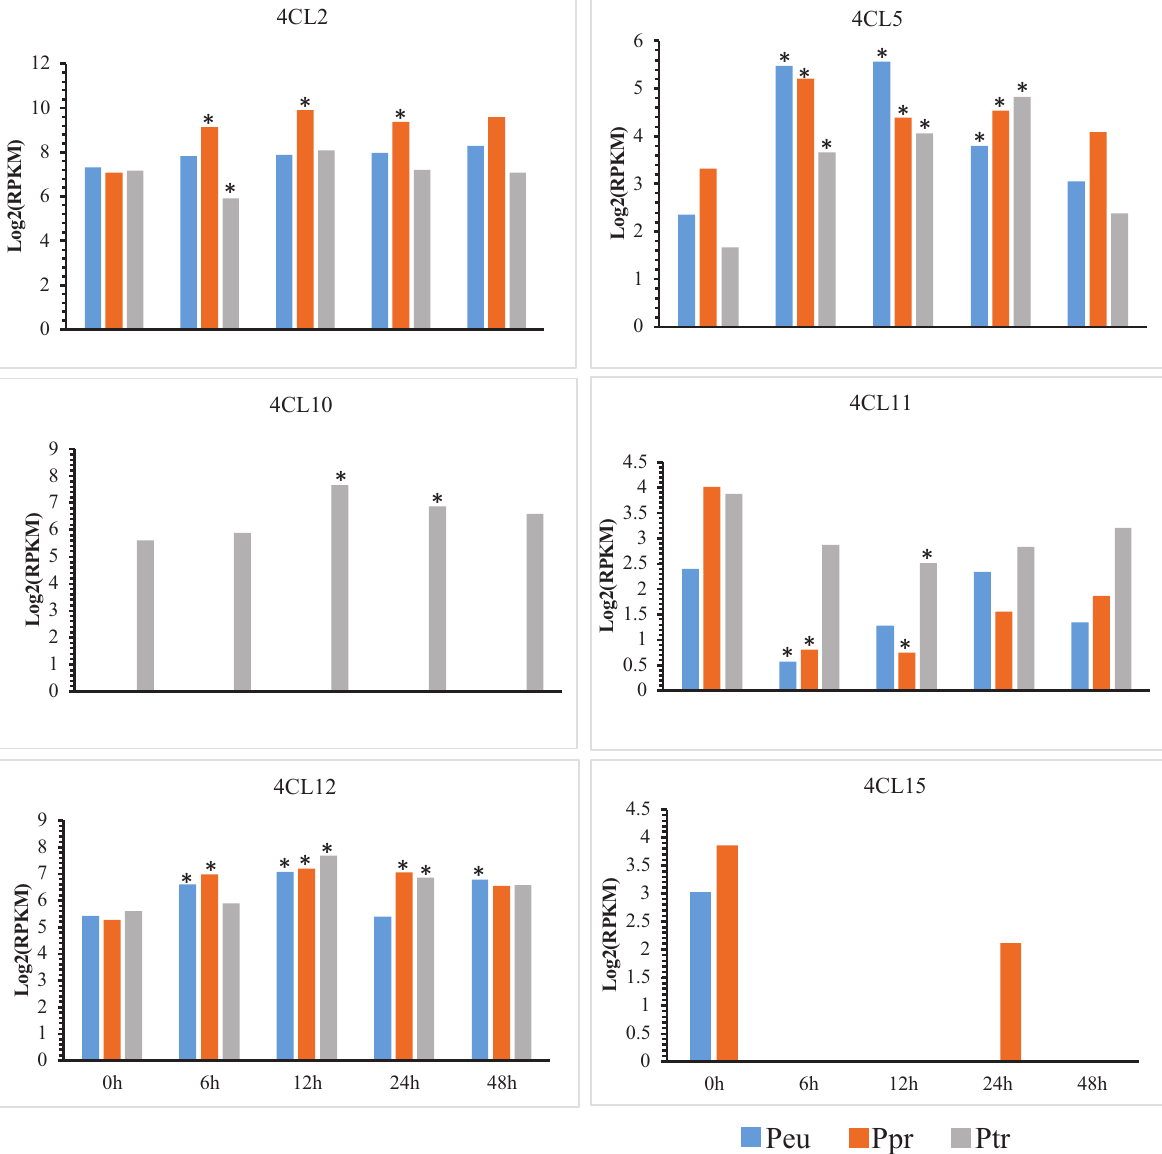
Figure 6. Expression analysis of the orthologous 4CL genes under salt stress. Transcription analysis of the relative expression levels of six orthologous 4CL genes specific to three species under salt stress except 4CL9 , which was not expressed in neither un-stressed nor stressed calluses, and the orthologous genes ( 4CL15 ) with (cid:2) ( dN/dS ) > 1 in P . pruinosa and P . euphratica . The y-axis shows the log2-transformed RPKM values of genes expressed in callus after different periods of salt stress, and the x-axis shows the time point under salt stress. The star (*) represents the expression of genes under salt stress that reached the threshold of log2 (RPKMsalt/RPKMcontrol) > 1 or < (cid:5)1 and indicates a significance of p <